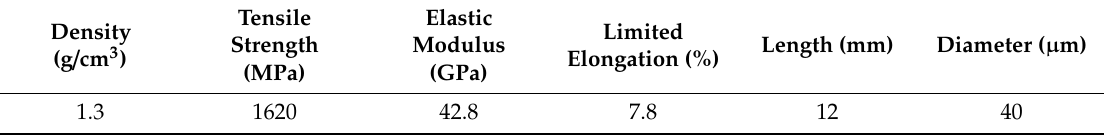
Table 4. Physical properties of polyvinyl alcohol (PVA) fiber.